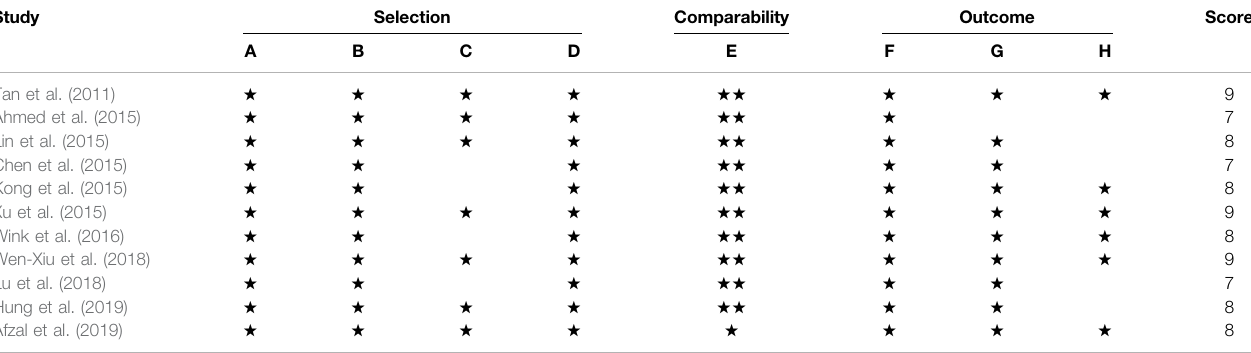
TABLE 3 | Quality evaluation of observational studies included according to the Newcastle-Ottawa Scale (NOS).